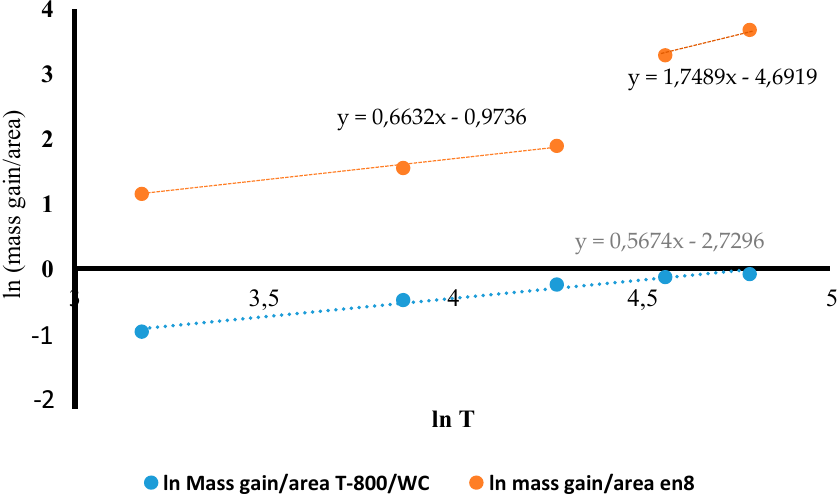
Figure 10. Plot of ln (mass gain/area) vs. ln T for the oxidation of EN8 and the T-800/WC coating at 800 °C for up to 120 h. Table 2. Kp constants for EN8 and